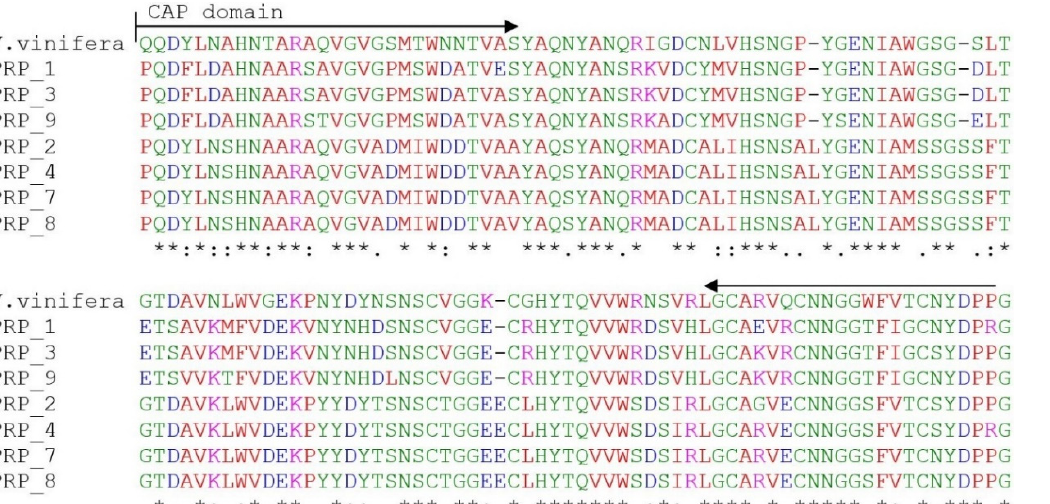
Figure 2. Amplified PCR fragments obtained with primer pairs PRPd and COId in Ribes species.